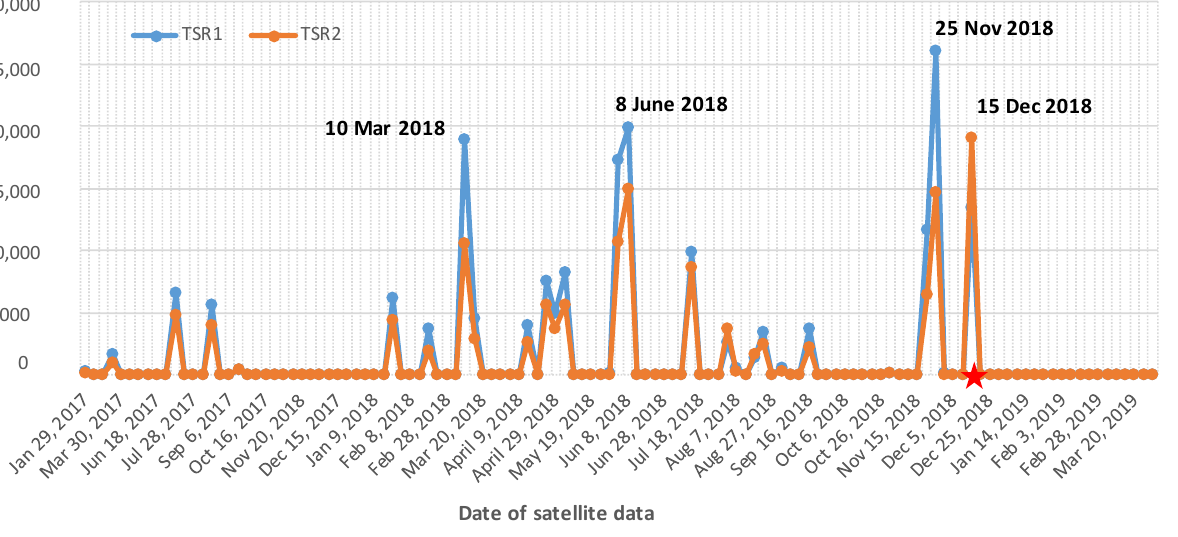
Figure 4. Temporal trend of the total SWIR1 (TSR1) and SWIR2 (TSR2) radiances that were computed over the Ambrym volcano, and generated from the S2-MSI data of January 2017 – March 2019. To assess the contribution of the lava lakes to changes in the total SWIR1 radiances that were recorded before the 15 December 2018 eruption, we computed the maximum value of the NHI SWNIR index over the Benbow and Marum crater areas. This analysis re- vealed that the NHI SWNIR index assumed negative values in presence of clouds/plumes, which subsequently affected the crater area. Moreover, on 25 November (i.e., correspond- ing with the peak of TSR1), the index increased in a more prominent way at the Marum crater (max NHI SWNIR = 0.78) rather than the Benbow (max NHI SWNIR = 0.64) crater, despite similarly extended cloud coverage ( ≈ 6% of cloudy pixels). This was estimated using the Sentinel Hub EO Browser [21]. Hence, when the differences in the number of extremely hot pixels at the craters are also considered (see Figure 3c), we can speculate that lava lakes at the Marum crater pro- vided a major contribution to the increase in total SWIR1 radiances recorded by the satel- lite before the 15 December 2018 lava effusion. Figure 5 displays the curves of the aforementioned indicator that was retrieved over the Benbow (blue curve) crater and the SE flank of the Marum crater (orange curve), using S2-MSI scenes from January 2017 – December 2019. The plot, which integrated L8-OLI and S2-MSI observations, shows that the NHI SWNIR index was always negative over the SE flank of the Marum crater regardless of cloud coverage, apart from the day of the fissure